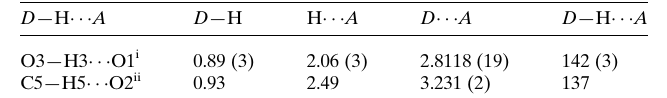
Table 1 Hydrogen-bond geometry (A˚ , (cid:2) ).